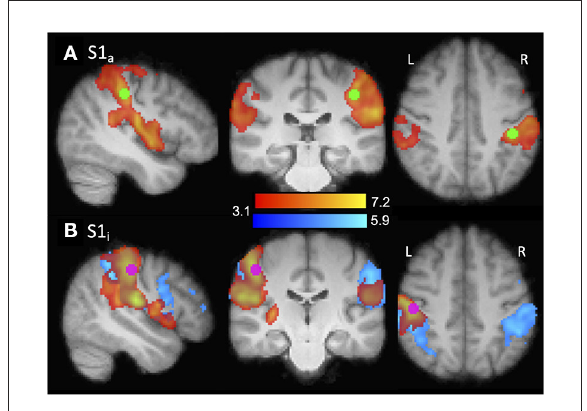
FIGURE2 Illustration of ROI localization. ROIs (purple/green) were functionally defined from the typical adult group contrasts shown (red/yellow). (A) S1a. Contrast: right hand > rest. ROI center: X = − 42, Y = − 30, Z = 42. Amputee group contrast also shown (blue). (B) S1i. Contrast: left hand > rest. ROI center: X = 48, Y = − 22, Z =